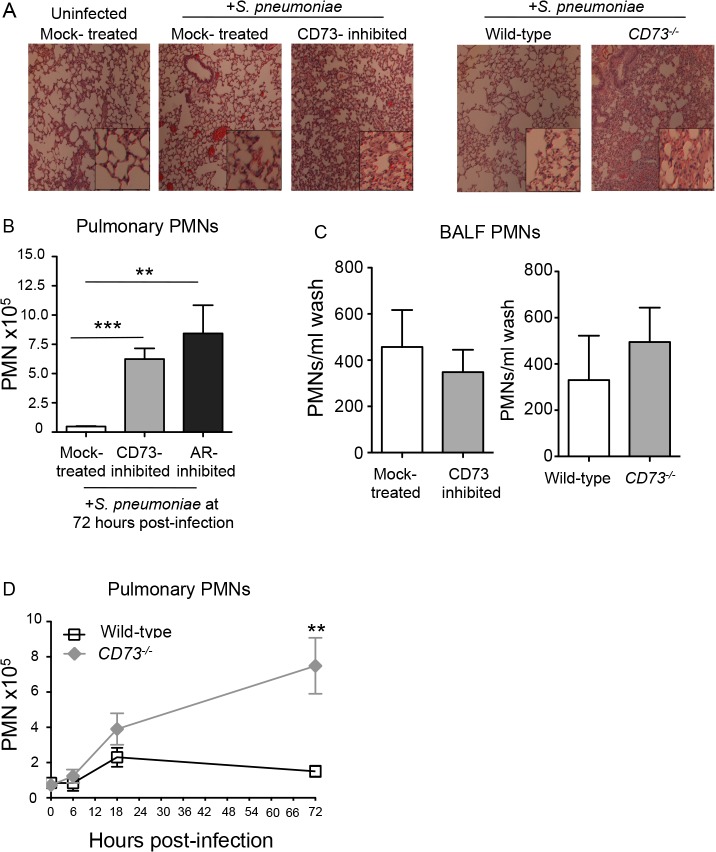
Inhibition of EAD production or signaling significantly increases PMN numbers in the pulmonary tissues.Wild-type untreated, mock-treated or CD73-inhibited C57BL/6 mice and CD73-ablated (CD73
-/-) mice were inoculated I.T. with 5x 103 CFU of S. pneumoniae TIGR4. (A) H&E-stained lung sections examined by light microscopy at 3 days post-infection (10× magnification; inset at 40x magnification). (B) The mean +/- SEM of pulmonary PMNs (Ly6G+ cells) in mock-treated, CD73-inhibited, or adenosine receptor (AR)-inhibited mice, measured by flow cytometry at 72 hours post-infection. Uninfected mice of the different treatment groups had comparable low numbers (less than 105) of PMNs in the lungs. (C) The number of PMNs in the bronchio-alveolar lavage fluid (BALF) was also determined by flow cytometry. (D) The mean +/- SEM of pulmonary PMNs of wild-type or CD73
-/- mice was determined over time at the indicated times post-infection. Pooled data from three separate experiments (Panels B and C n = 8–9 mice per group; Panel D n = 6–9 mice per group) are shown. Statistically significant differences determined by student’s t-test are indicated by asterisks (*** = p< 0.0001; ** = p< 0.001; * = p<0.05).